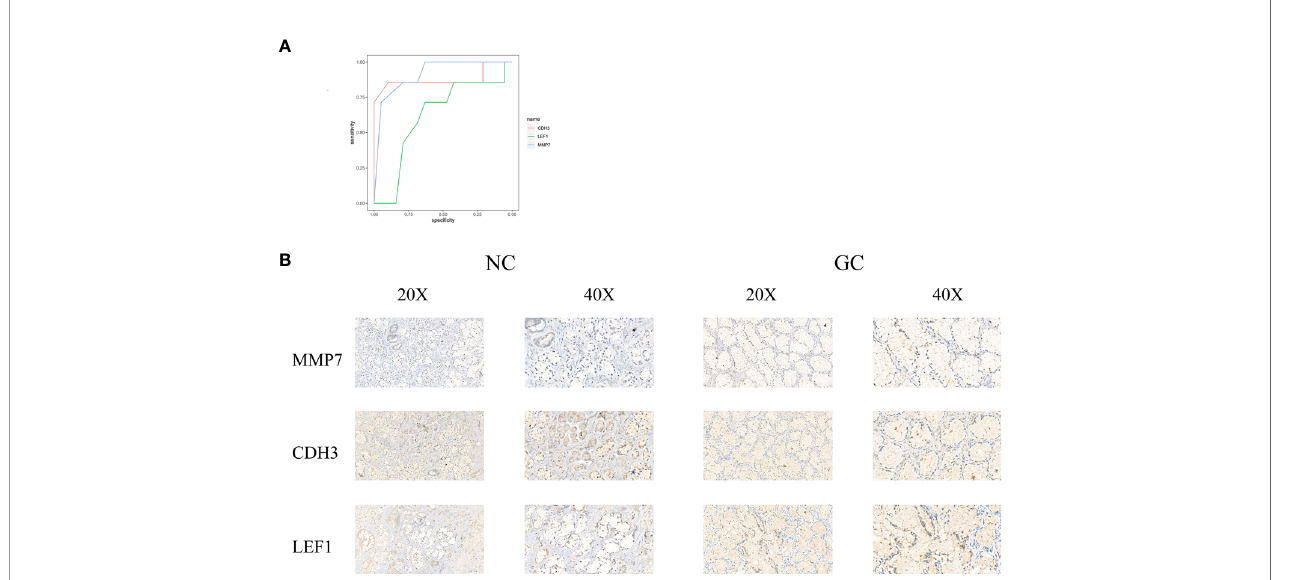
FIGURE 12 | (A) The ROC of three genes for gastric cancer. (B) The detection of MMP7, CDH3, and LEF1 in the gastric tissues by immunohistochemical staining with their own antibodies. (200X,